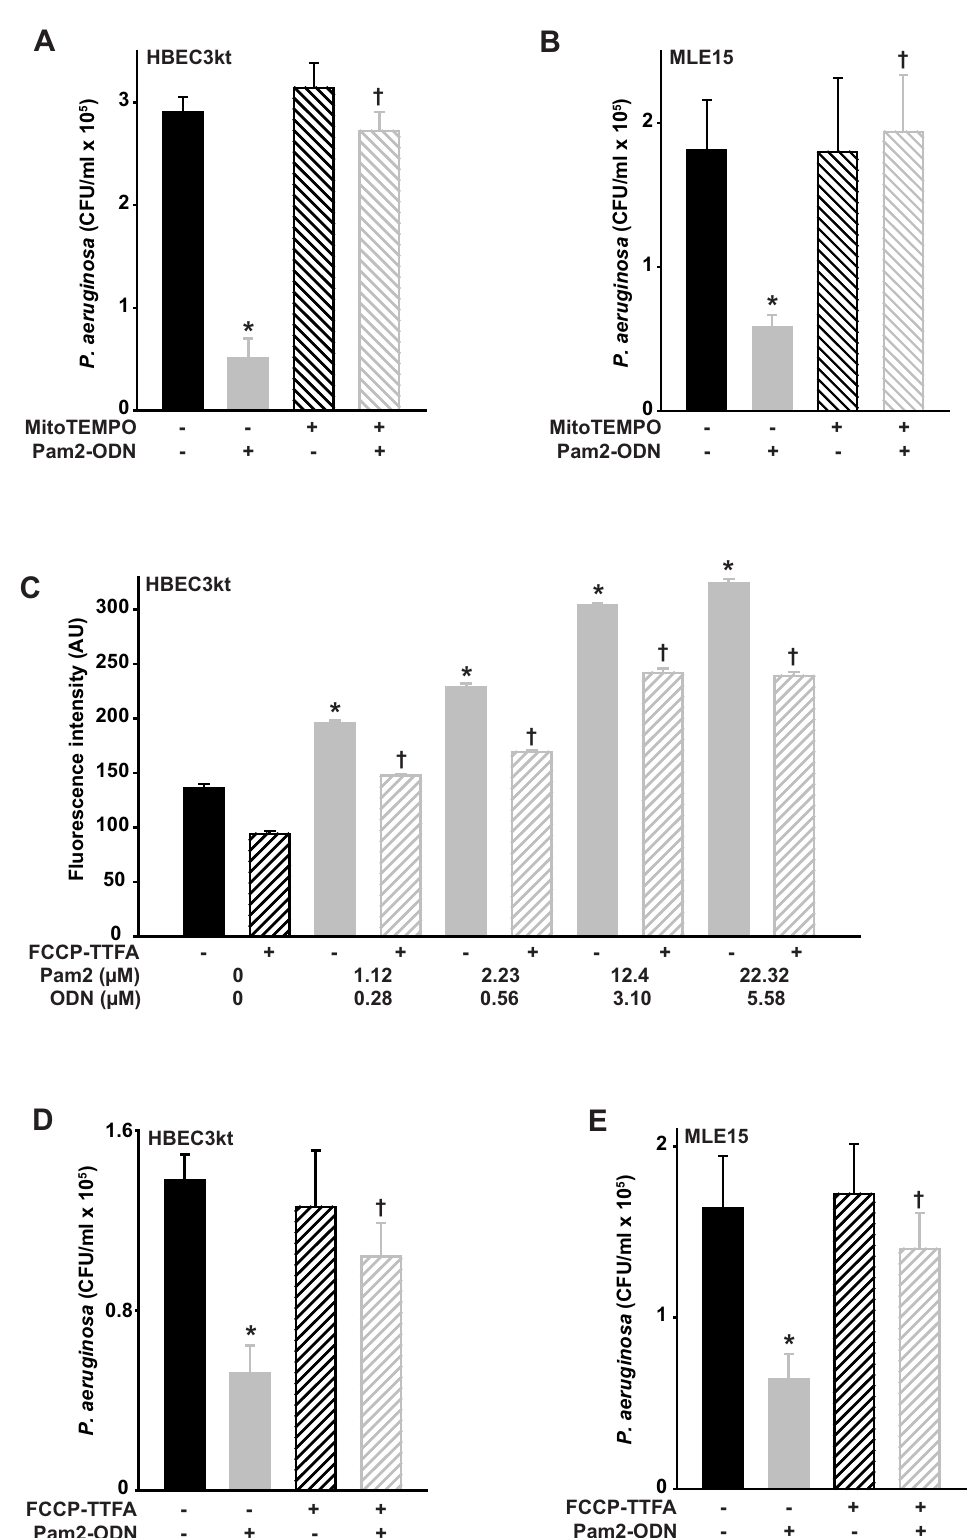
Fig 4. Mitochondrial ROS are required for Pam2-ODN-induced antibacterial epithelial responses. HBEC3kt ( A ) or MLE15 ( B ) cells were pretreated with MitoTEMPO or PBS, treated for 4 h with PBS or Pam2-ODN (Pam2 2.23